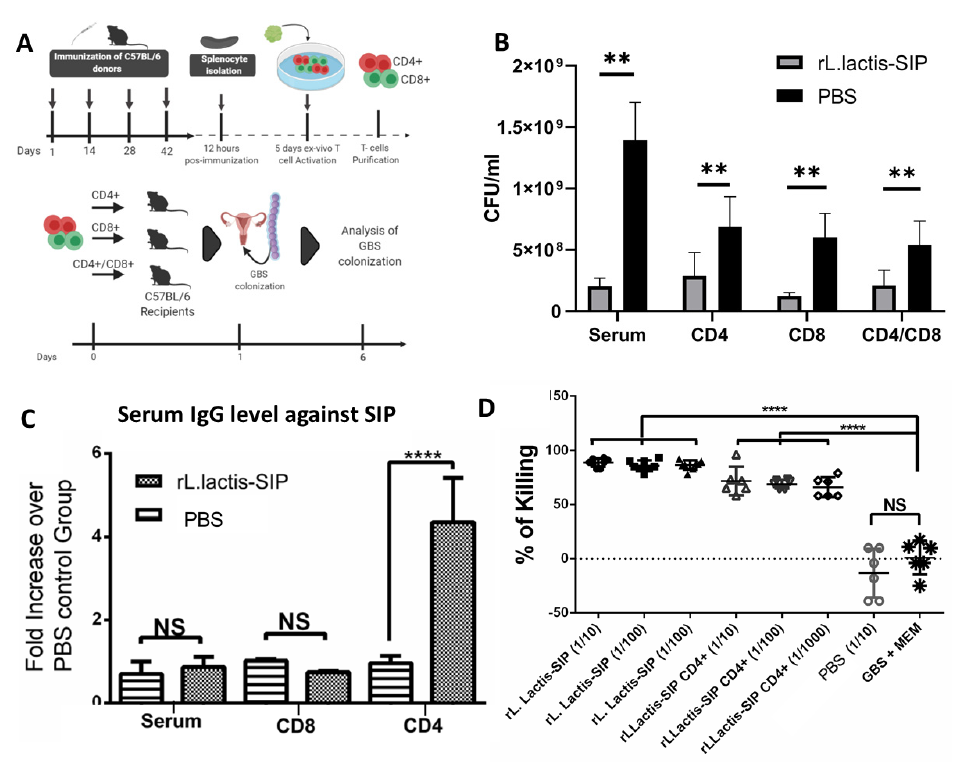
Figure 5. Serum and T cells from rL. lactis -SIP promoted a protective immunity to GBS vaginal colonization. ( A ) C57BL/6 mice were orally immunized with rL. lactis SIP and PBS and boosted 14, 28, and 42 days later. Then, 12 h after the last immunization, mice were sacrificed, and splenocytes were collected for in vitro culture. Cells were stimulated with 1 μ g/mL of purified rSIP and cultured for 4 days. Total cells were pooled, and T cells were purified with Mojosort isolation kits. A total of 1x10 6 purified CD4+, CD8+, or a 1:1 mixture of CD4+ and CD8+ T cells was intravenously injected into naïve mice, and 24 h later, mice were vaginally colonized with 1x10 7 CFU of GBS. Sera from all groups were used to transfer into immunized naïve mice. ( B ) Reduction of GBS vaginal colonization for CD4+, CD8+-, or CD4+/CD8+, and serum from-transferred mice. Data are shown as mean ± SD of eight mice in each group. Asterisks indicate a difference between groups (** p < 0.001). ( C ) The secretion of IgG against SIP was measured by ELISA from the sera collected from mice that received T cell and serum transfers and were infected after 4 weeks post-colonization. One of two independent experiments with similar results is shown. Data are shown as mean ± SD of four mice in each group. Asterisks indicate a difference between groups (not significant (ns); **** p < 0.0001). ( D ) After 4 weeks, the sera of the recipient animals that received the transfer of CD4 + rL. lactis -SIP T cells were tested by opsonophagocytic assay (OPA). OPA was used to test the opsonic killing of GBS from antibodies secreted by the rL. lactis -SIP vaccine and CD4+ T cell-transfer mice. The points show the OPA of serum in the presence of GBS, rabbit complement C ′ , and human promyelocytic leukemia cells (HL-60 cells). The OPA assay was performed with a ratio of effector cells to GBS cells of 90:1. The percentage of killing for the sera and the corresponding dilution used in the OPA are indicated. The control reactions contained dilutions that lacked antibody or complement or contained normal rabbit serum resulted in GBS growth. **** p < 0.0001 by multiple-test ANOVA for serum dilutions of 1:10, 1:100, and 1:1000 compared with normal GBS culture in the presence of minimum essential medium (MEM). Data are shown as mean ± SD of eight mice in each group. Asterisks indicate a difference between groups (not significant (ns); **** p < 0.0001).